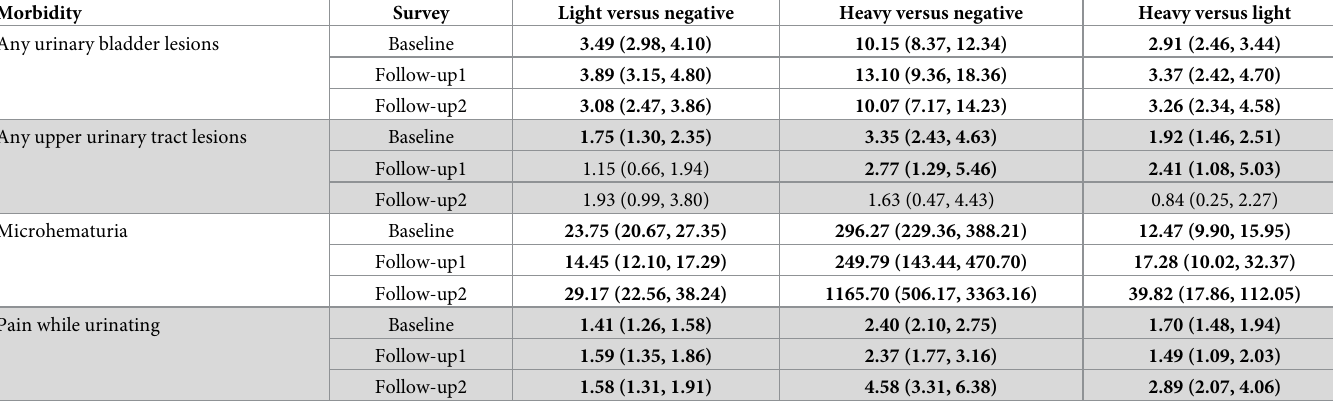
Table 3. Odds ratios (ORs) and 95% credible intervals from Bayesian logistic regression models comparing morbidity positive proportions between intensity cate- gories within surveys for S . haematobium -related morbidities without controlling for age and sex. Bold font indicates the 95% Bayesian credible interval (BCI) does not contain one. Participants are school-age children (6–15 years), enrolled between 2003 and2008 in Mali, Niger, and